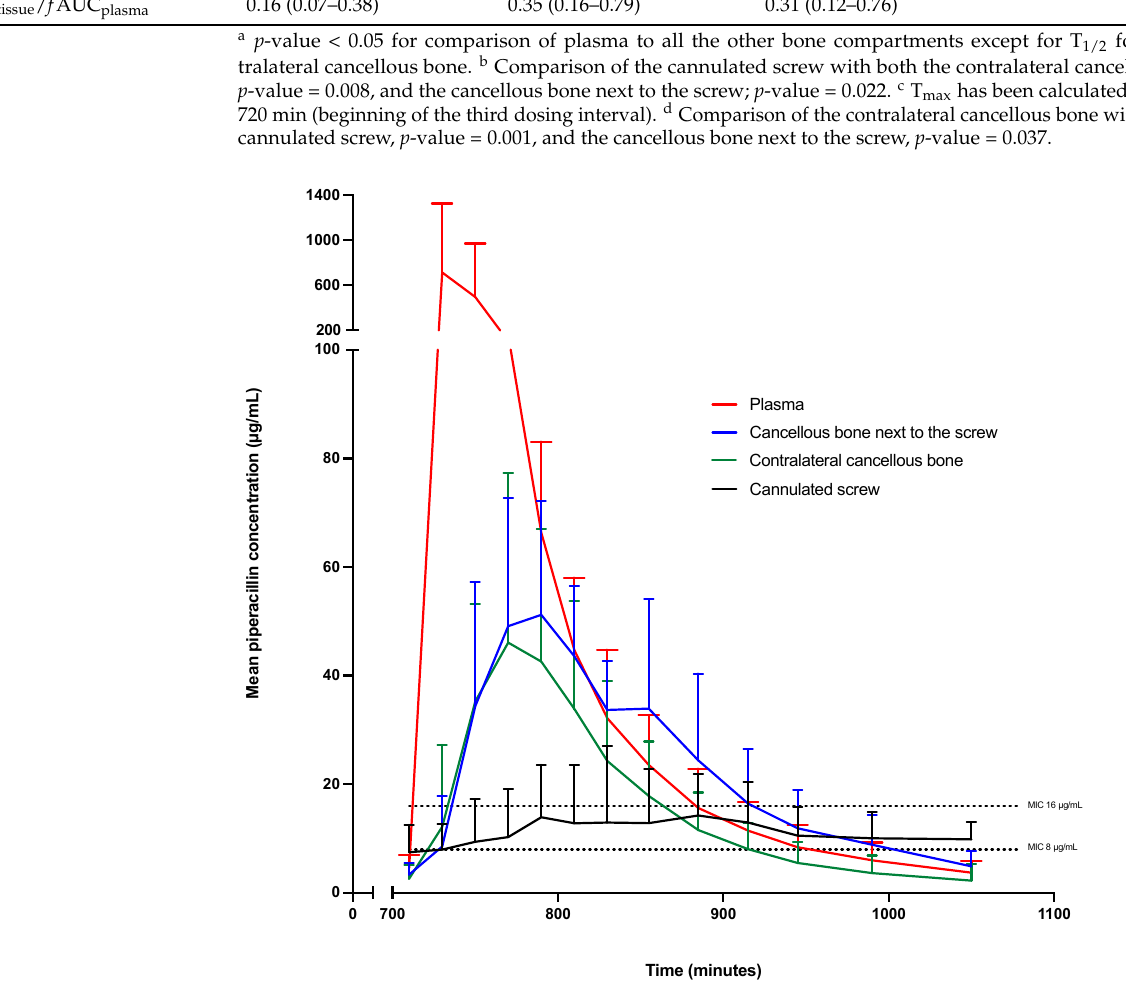
Figure 1. Mean concentration–time profiles of piperacillin in the cannulated screw, the cancellous bone next to the screw, in the contralateral tibia and plasma for the third dosing interval (steady- state concentration). The error bars represent 95% confidence intervals. The left Y-axis shows a two-segmented axis in order to contain all graphs. The X-axis also shows a two-segmented axis to illustrate the true time for sampling.